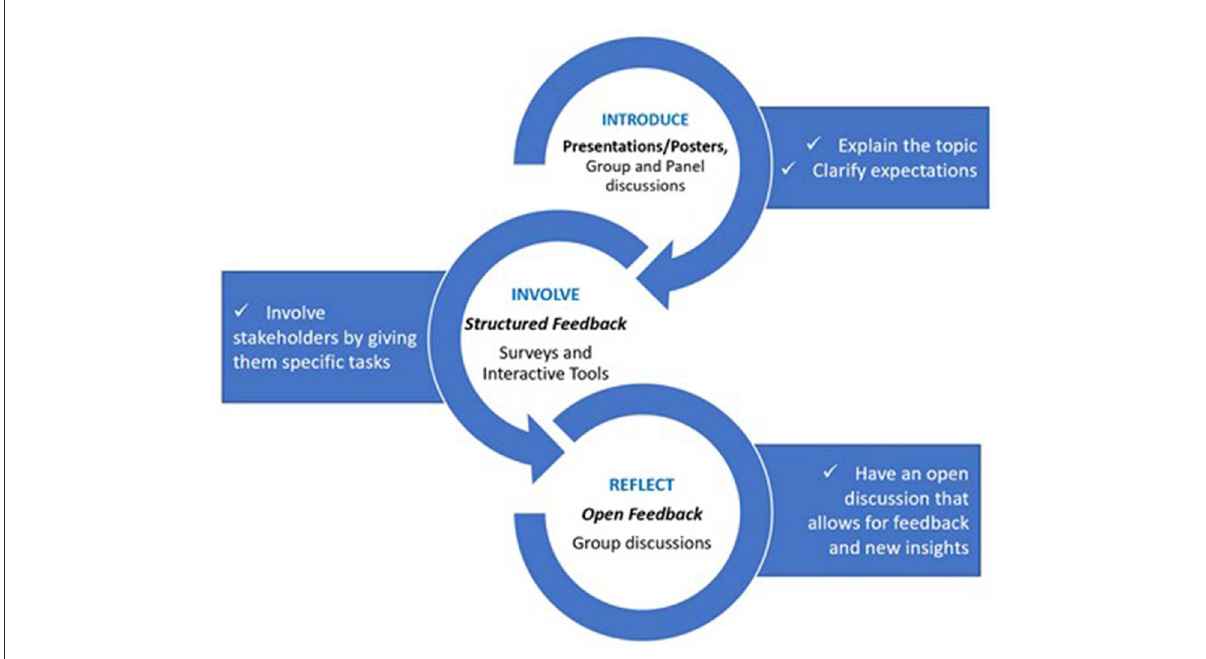
FIGURE1 Tools and approaches to achieve the diverse goals of stakeholder engagement in the ENGAGE